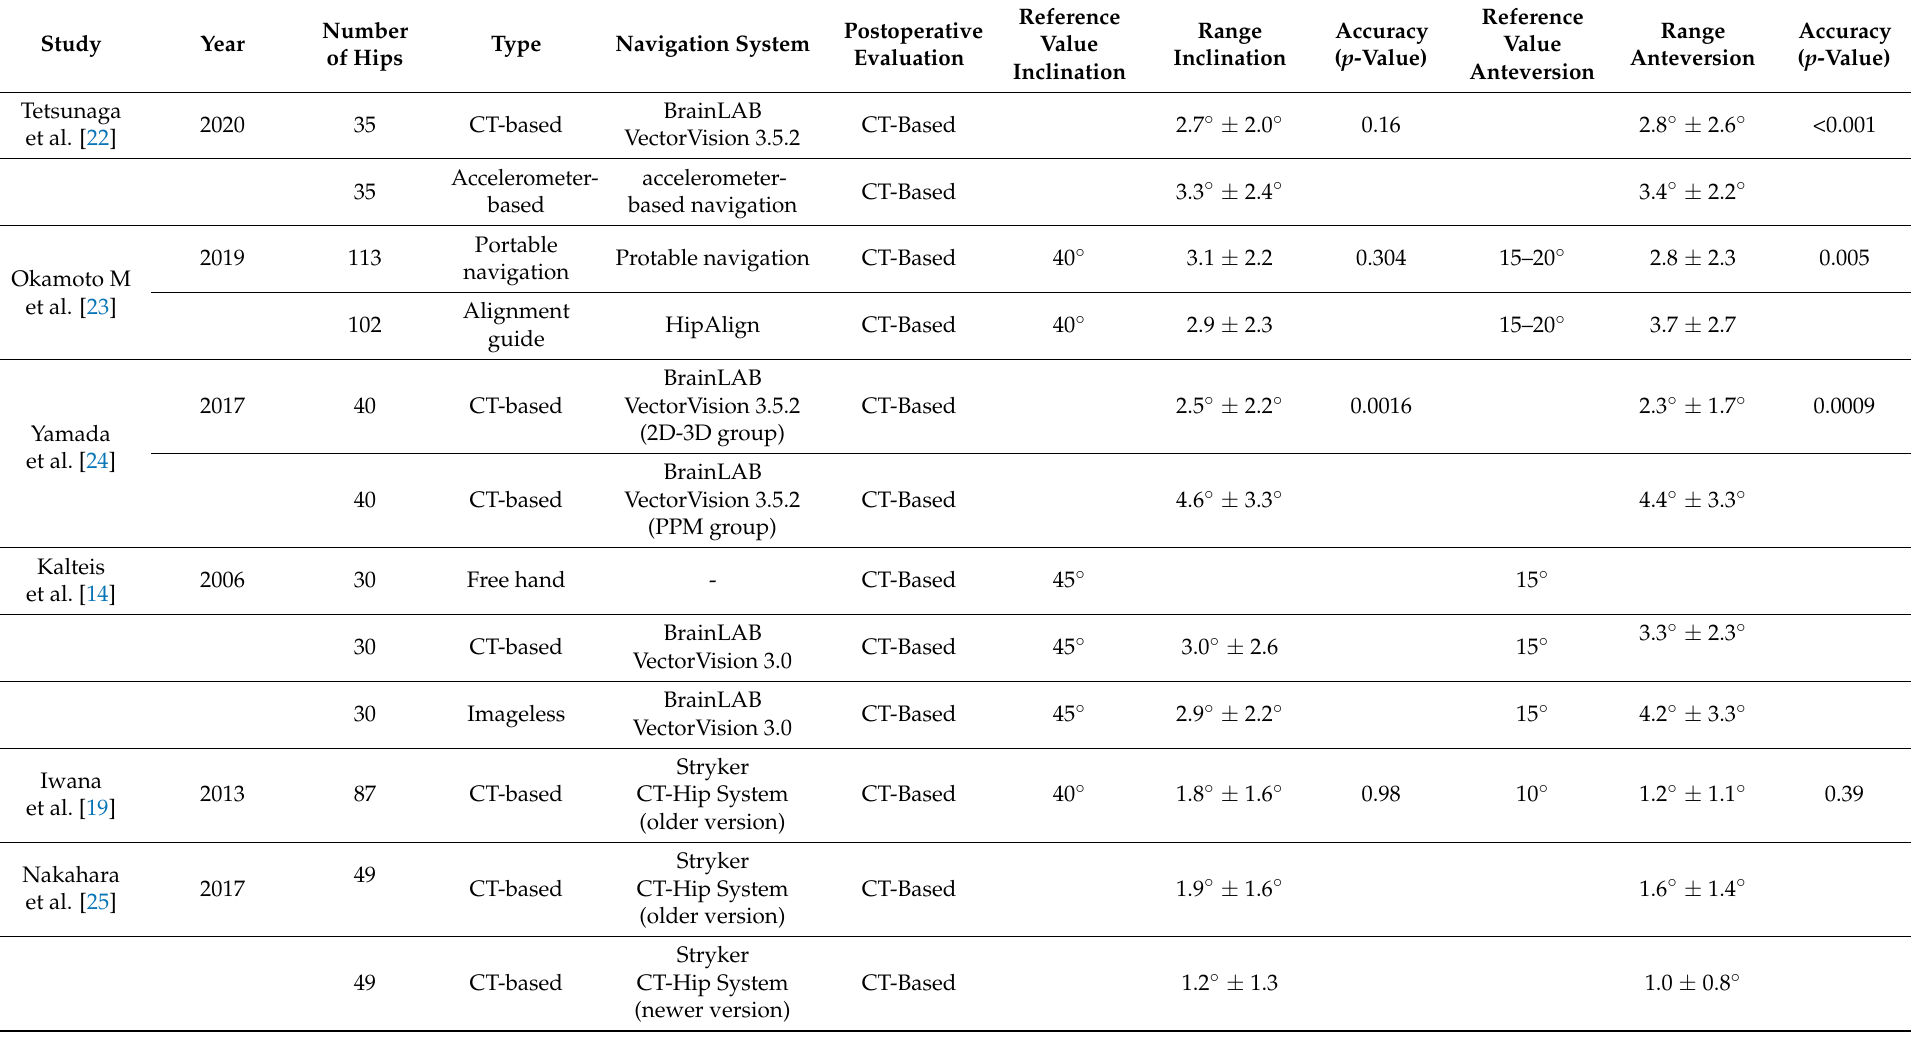
Table 3. Summary of